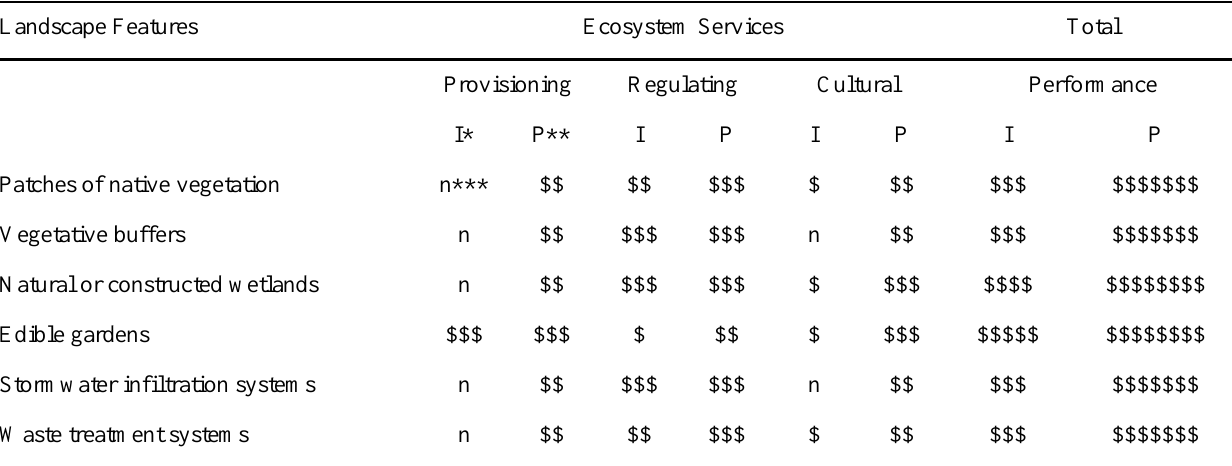
Table 1 . Inherent and potential contributions of different design elements to different ecosystem services in intensively managed